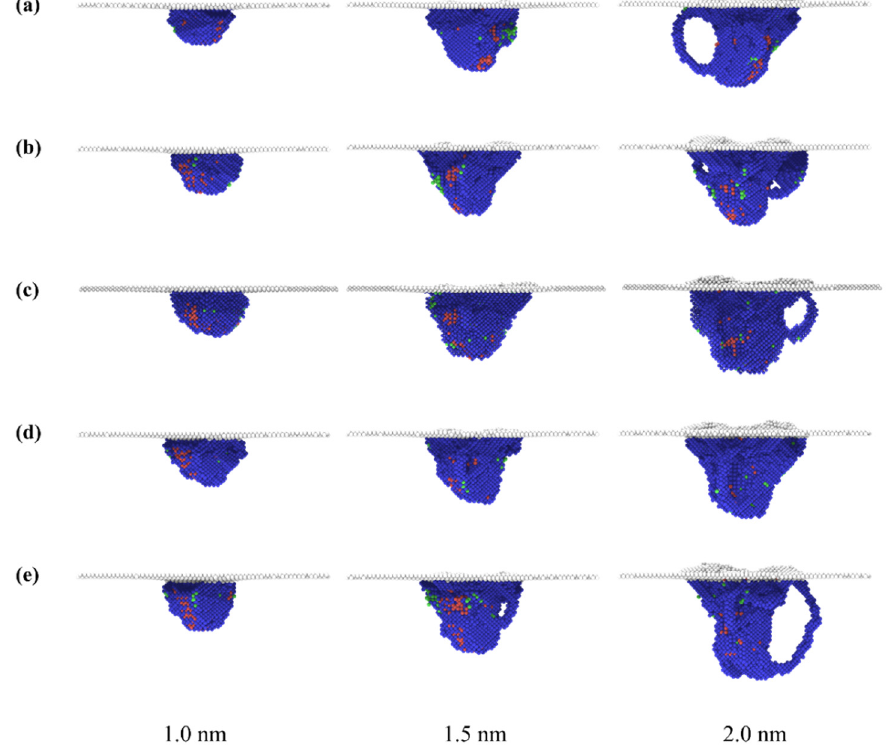
Figure 5. Instantaneous atomic configurations of various Zr content ( a – e ) under different depths (1.0–2.0 nm), respectively. ( a ) 0 wt.%, ( b ) 2 wt.% ( c ) 3 wt.%, ( d ) 4 wt.% and ( e ) 5 wt.%. Except for boundary atoms shown in white, atoms inside the substrate are colored according to CNA, as HCP atoms (green), BCC atoms (yellow), and the other atoms (blue).